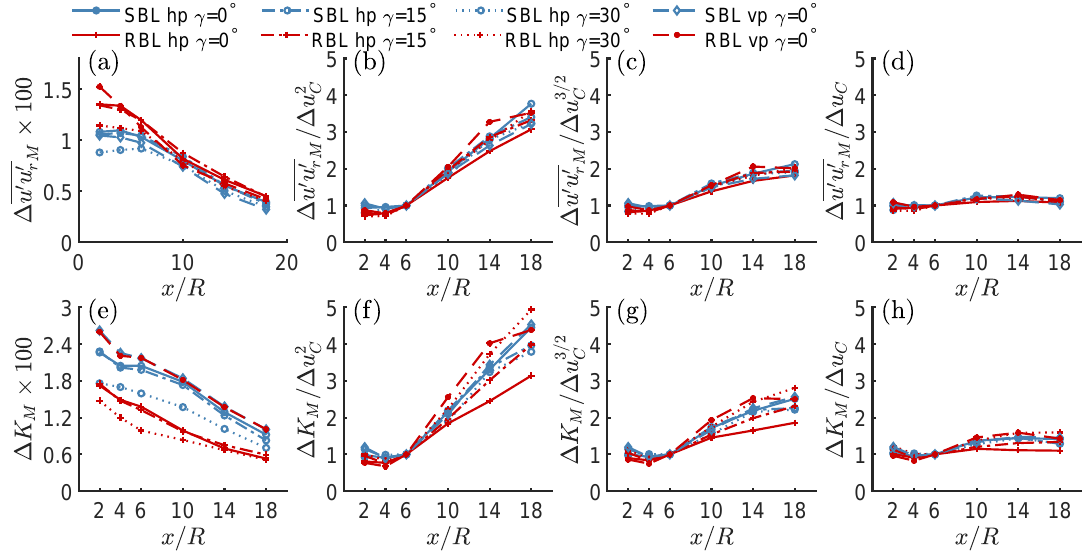
Figure 14. ( a ) Maximum added Reynolds shear stress ∆ u (cid:48) u (cid:48) rM and ( e ) maximum added turbulent kinetic energy ∆ K M in the wake of the model wind turbine, measured in the horizontal (hp) and vertical plane (vp), normalised using ( b )/( f ) equilibrium scaling ∆ u 3/2 growth scaling ∆ u C ∝ x , ( d )/( h ) linear wake growth scaling ∆ u 1/2 and yaw conditions.